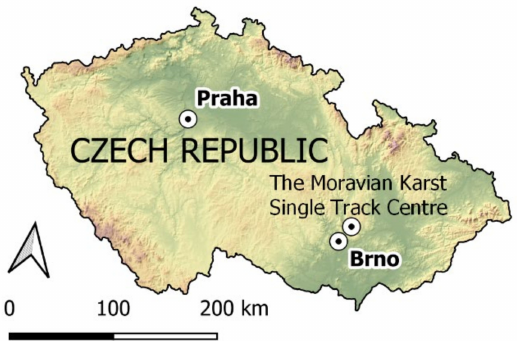
Figure 1. Location of the study area the Moravian Karst Single Track Centre in the Czech